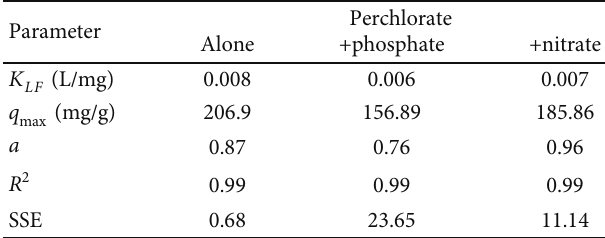
Table 3: L-F model parameters for anion